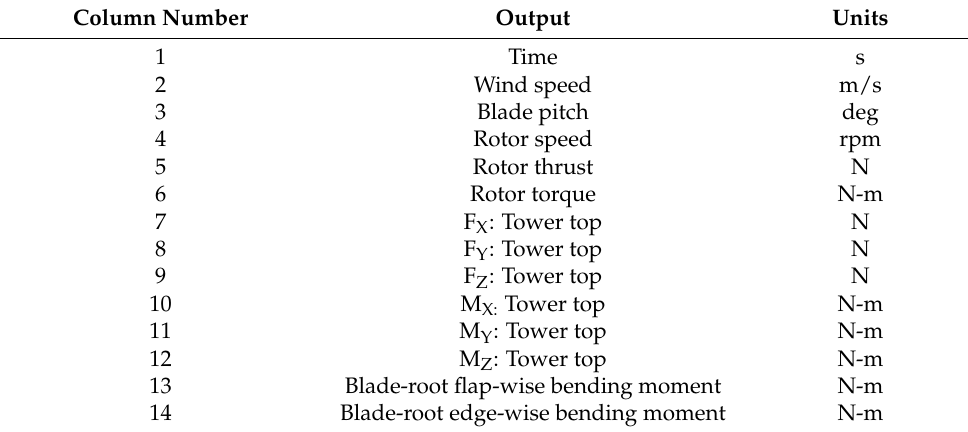
Table 5. Output channel